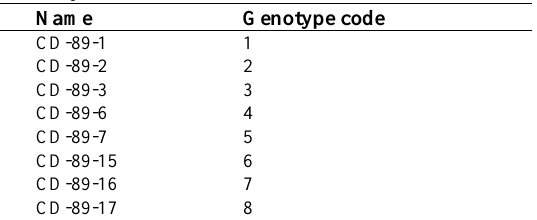
Table 1. List and code of eight wheat genotypes used in this